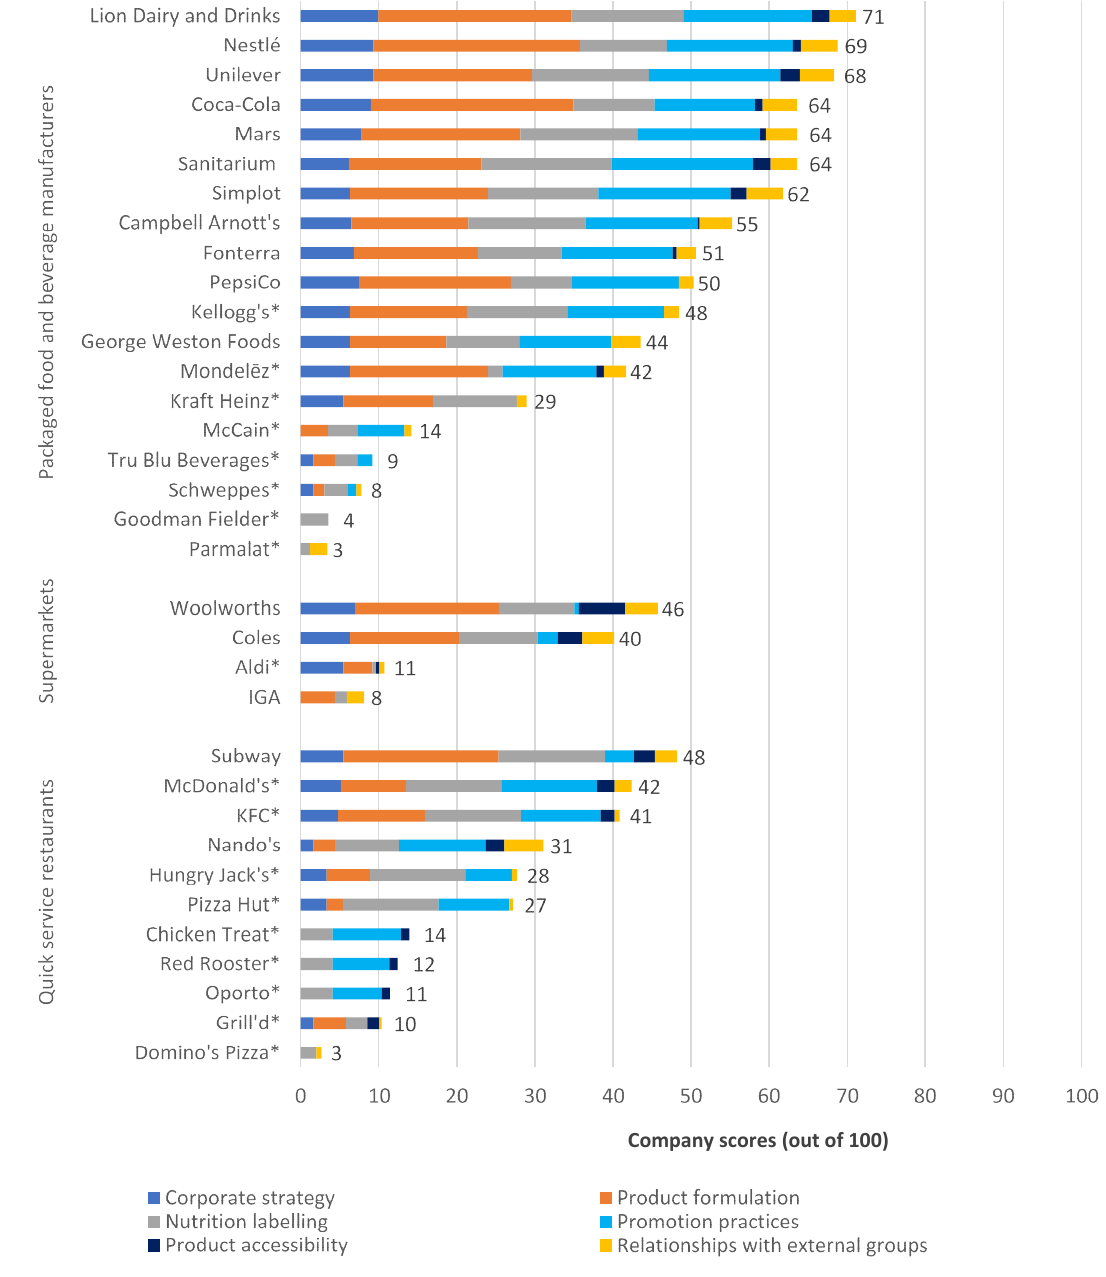
Figure 2. BIA-Obesity Australia 2018, company scores by sector (out of 100); *Assessment based on publicly available information only.